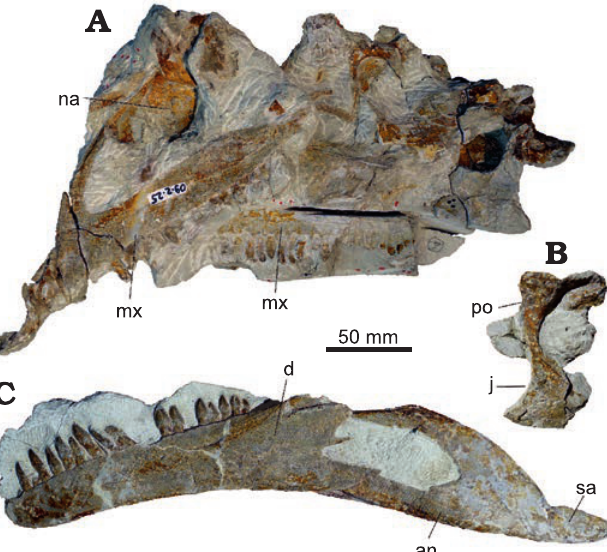
Fig. 12. Partly disarticulated skull of Plateosaurus trossingensis (MSF 09.2) from the Triassic of Frick, Switzerland. A . Main piece, showing the left lateral side of parts of the skull. B . Partial right postorbital and jugal in lateral view. C . Lower jaw in lateral view. Abbreviations: an, angular; d, dentary; j, jugal; mx, maxilla; na, nasal; po, postorbital; sa,